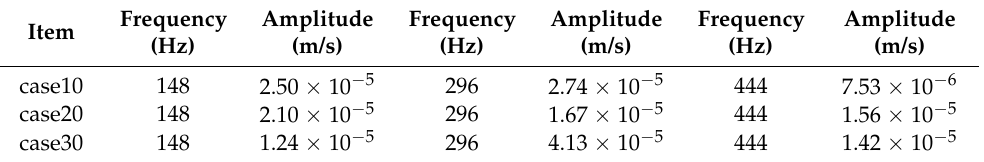
Table 3. The frequencies and corresponding maximum amplitudes of axial velocities for different cases. cases.